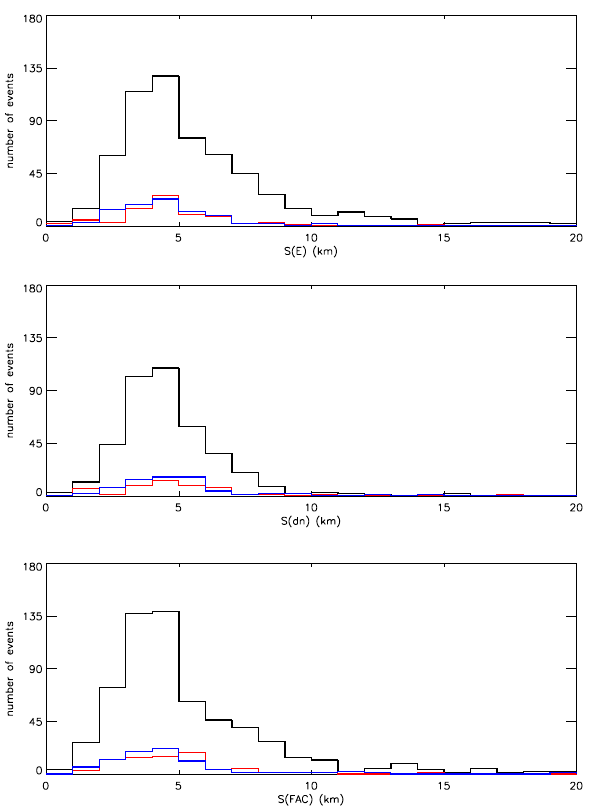
Fig. 2. The number of events versus FAC width, proton gyroradius and proton inertial length, black lines represent monopolar events while red and blue lines represent converging and diverging bipolar events, respectively. Note the increased range on the x-axis (com- pared to Fig.